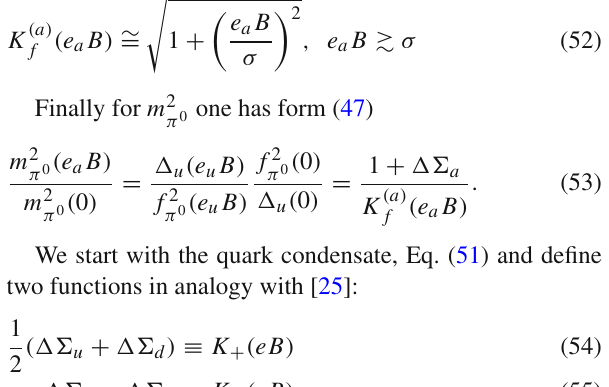
lattice data for all measured eB ≤ 1 . 1 GeV 2 . One notice two important distinctions of our and lattice results with the ECL